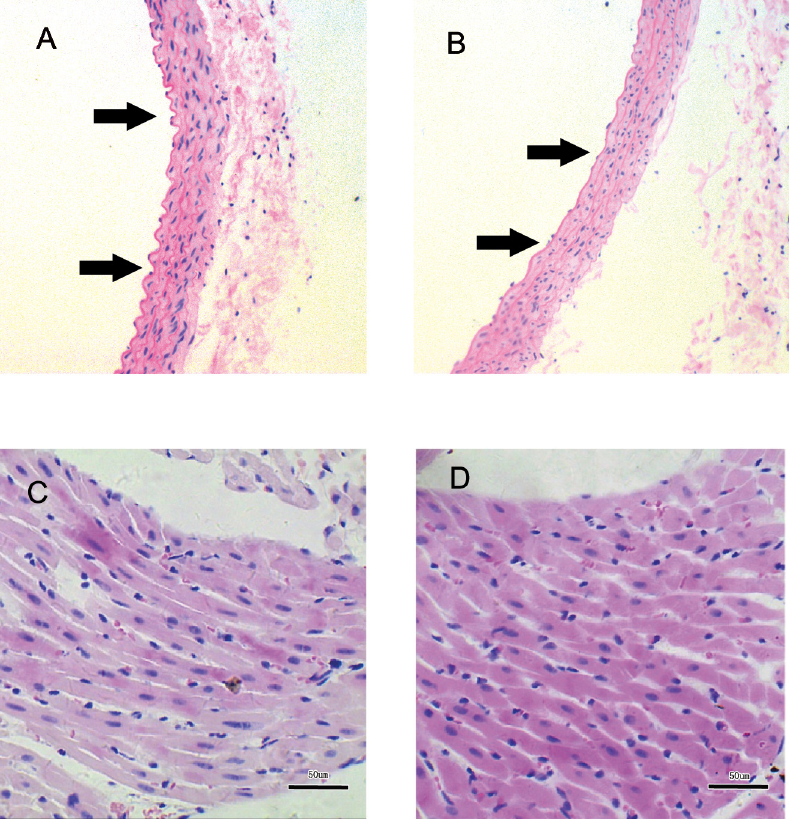
Fig 2. The histological structure of SD rat aorta and cardiac tissue by H&E staining method at day 40 after Pb exposure. A is the aorta tissue of control rat and B is the aorta tissue of Pb exposed rat (100×). C is the cardiac tissue of control rat and D is the cardiac tissue of Pb exposed rat